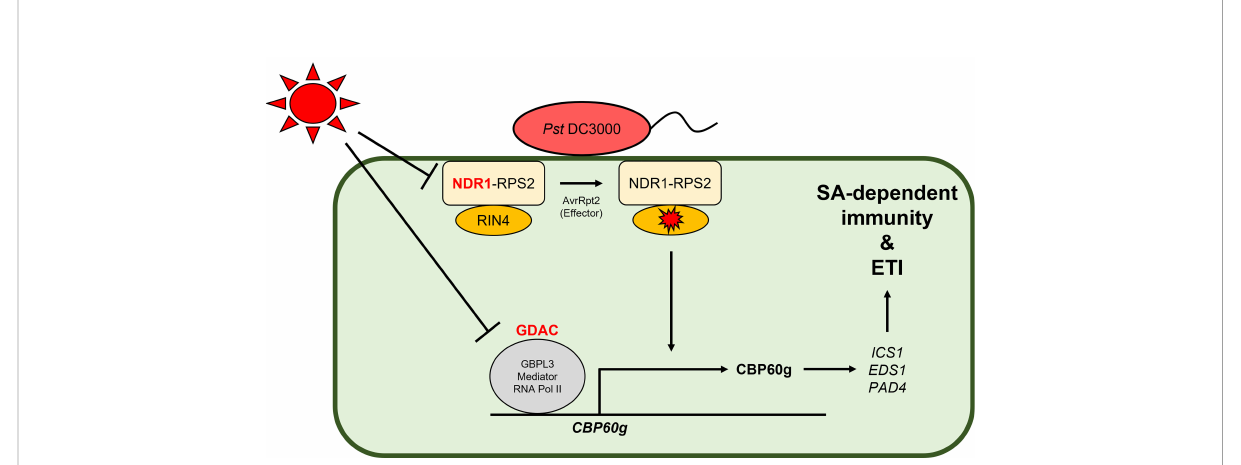
FIGURE 1 Molecular mechanisms demonstrating the negative effect of high temperature on SA-dependent immunity and ETI. In Arabidopsis, the induction of CALMODULIN BINDING PROTEIN 60g (CBP60g) and NON-RACE SPECIFIC DISEASE RESISTANCE 1 (NDR1) is necessary for innate immunity against Pst DC3000. However, under high temperature, the formation of guanylate binding protein-like GTPase (GBPL) defense-activated condensate (GDAC), consisting of GBPL3, Mediator, and RNA polymerase II, at the CBP60g loci (Kim et al., 2022) and the expression of NDR1 which can increase the transcript levels of RESISTANCE TO P. SYRINGAE 2 (RPS2) and SA-associated genes (Samaradivakara et al., 2022) are repressed signi fi cantly, resulting in temperature vulnerability of SA-dependent immunity and